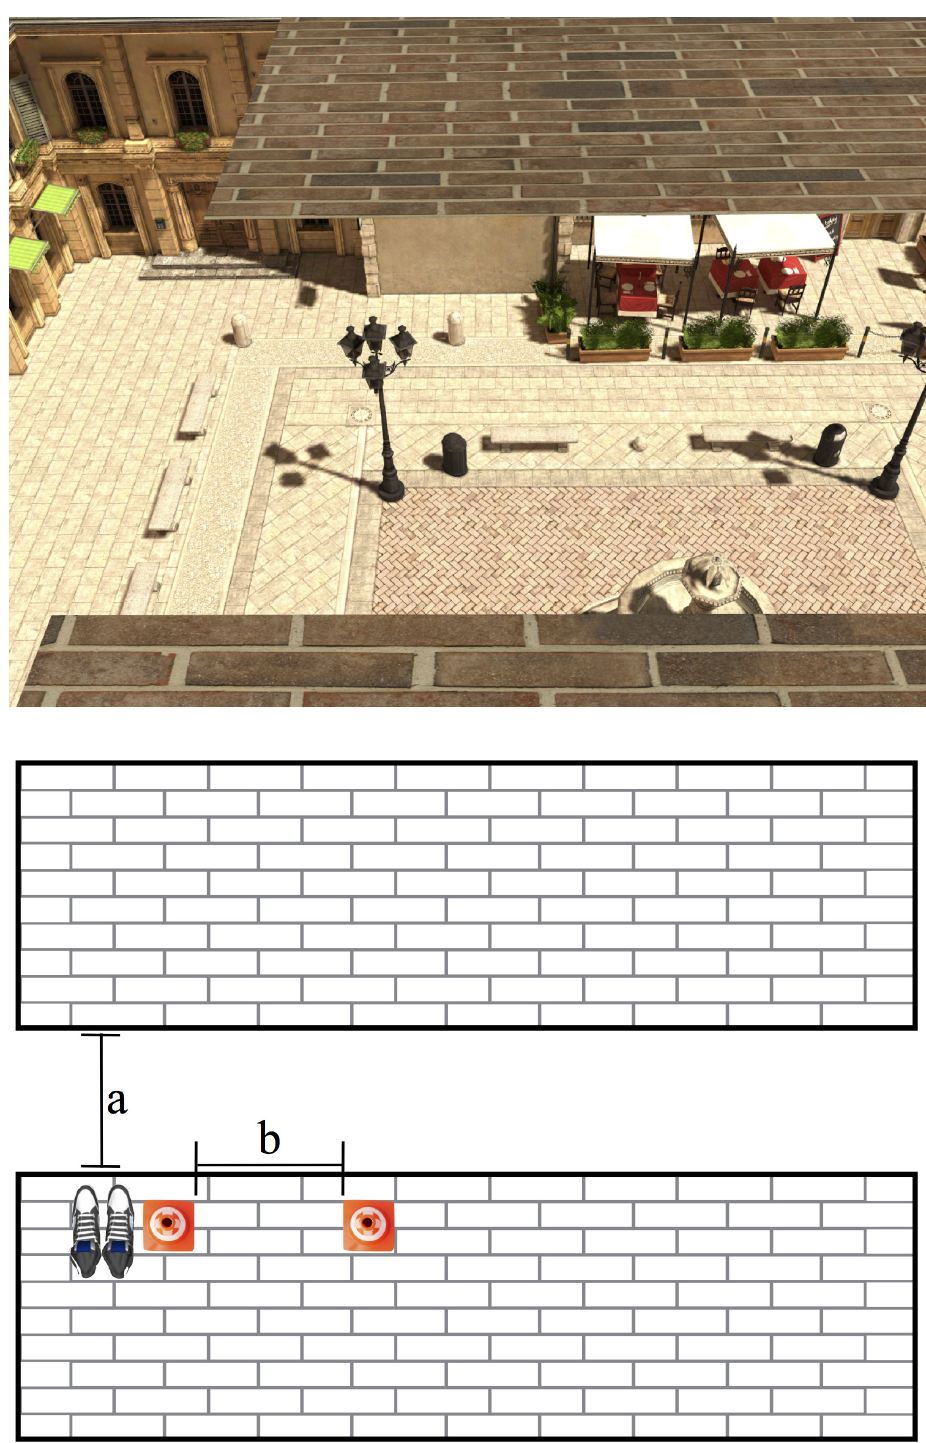
Fig 1. Virtual Environment. Screenshot of the virtual environment viewed from the participant ’ s standing location and schematic drawing of the estimation task (not-to-scale). Participants began the trials standing on the near brick platform and were tasked with estimating the distance from the edge of the near brick platform to the edge of the far brick platform (a) by adjusting the distance between two cones placed to the right of the participant (b). Participants only stepped across the gap in Experiment